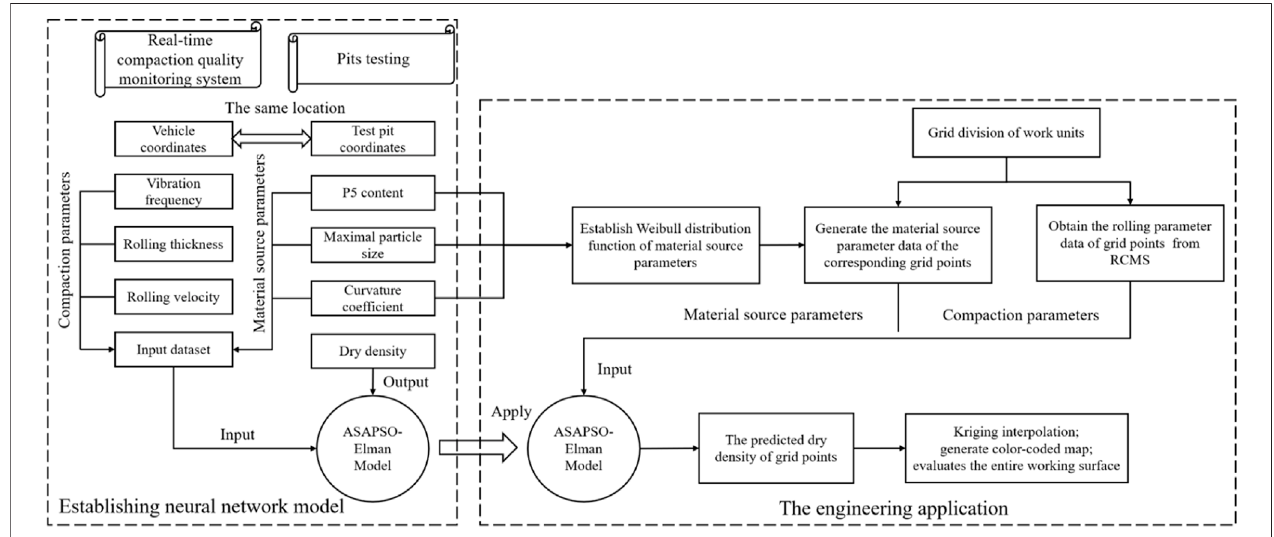
FIGURE 1 | The framework of the proposed